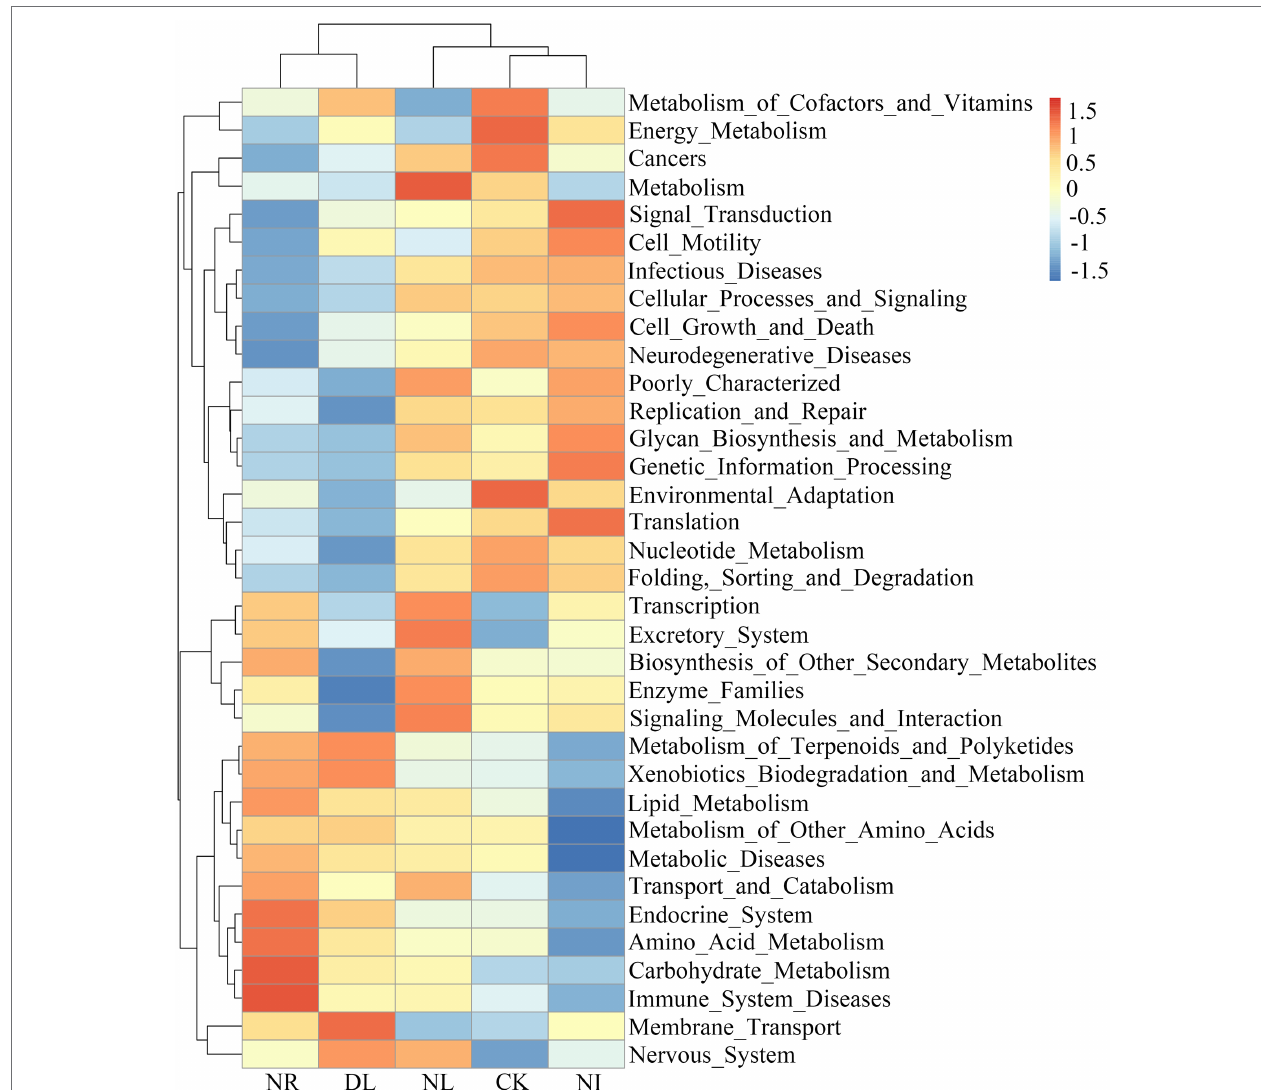
FIGURE 6 | Changes in functional groups of soil bacteria under different treatments. CK, DL, NL, NR, and NI represent control, doubled litter input, litter removal, root exclusion, root and litter exclusion,